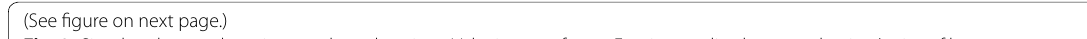
Table 1. The focal mechanism of S1 is taken from a M w